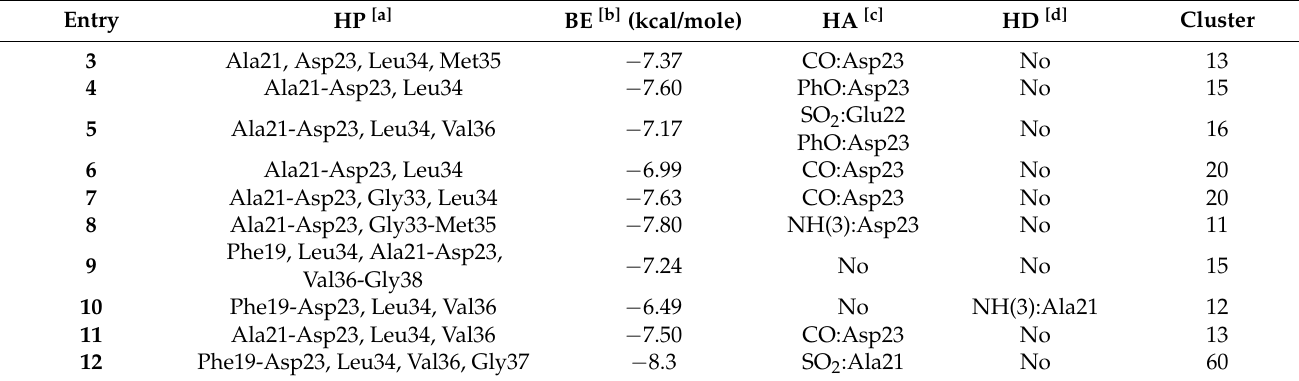
Table 6. Binding energy and interaction of new designed structure with 2BEG.